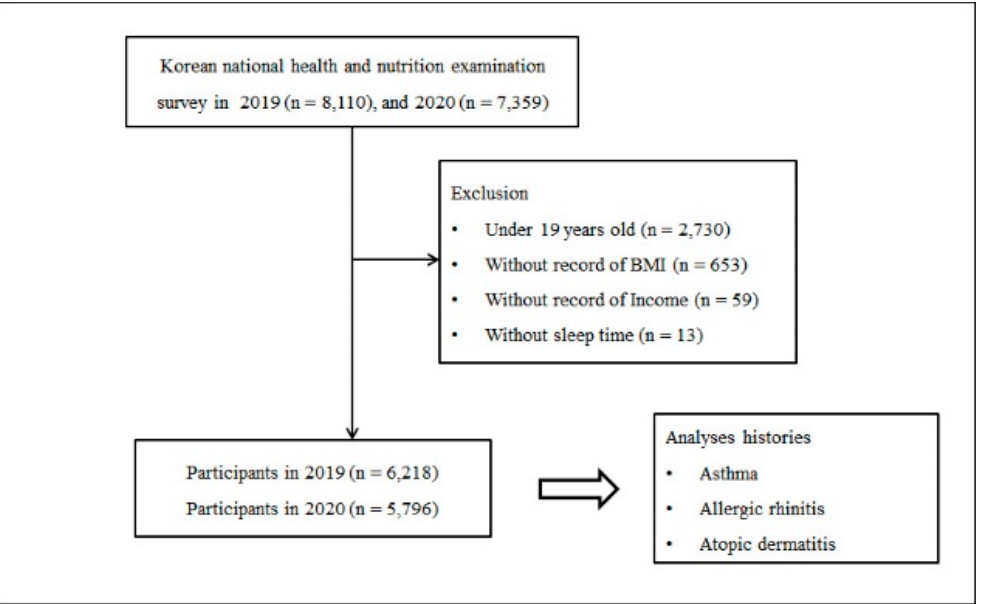
Figure 1. A schematic illustration of the participant selection process. Of 15,469 participants, data from 6218 in 2019 and 5796 in 2020 were compared. Abbreviations: BMI, body mass index